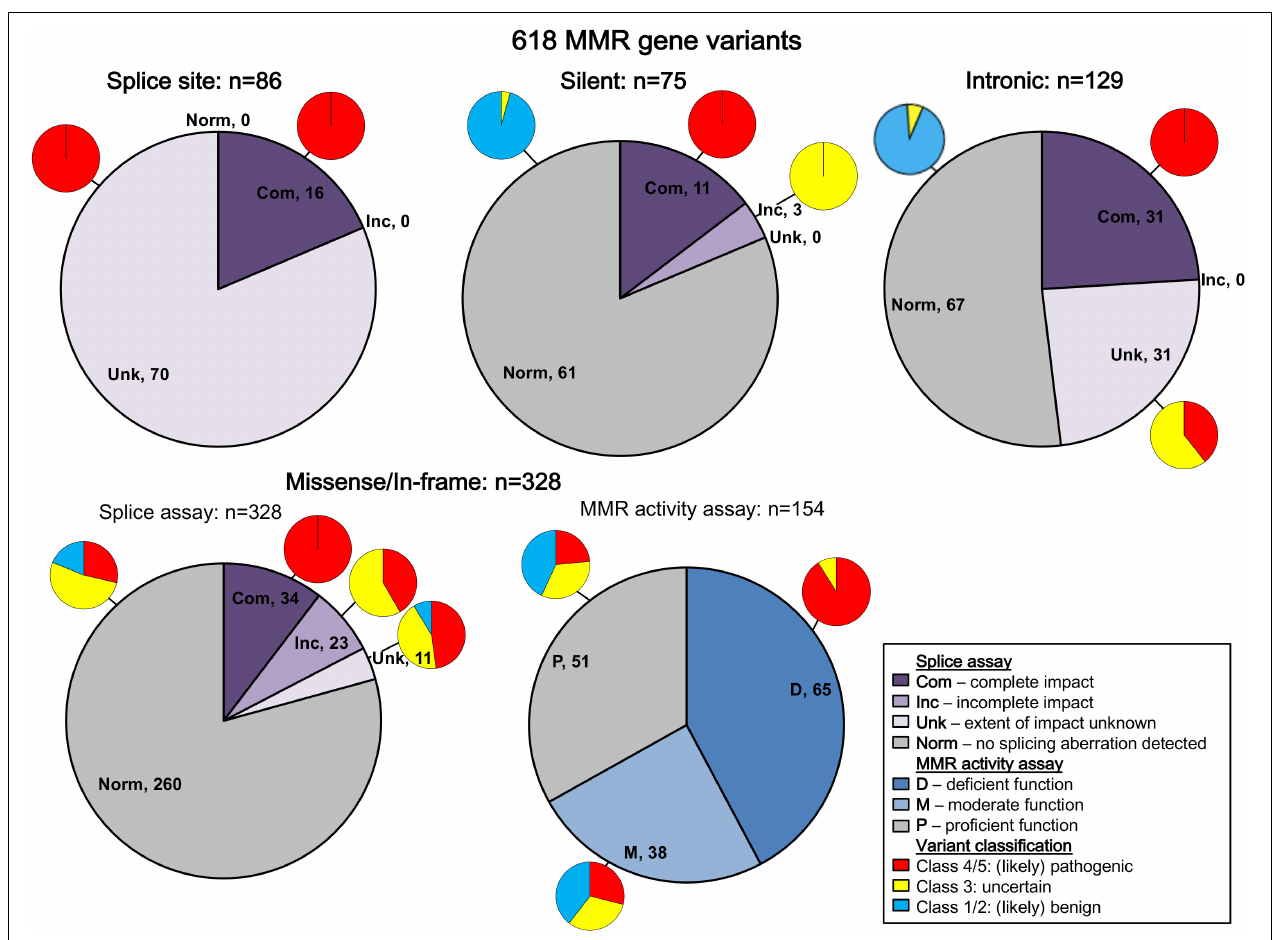
FIGURE 2 | Summary of contribution of splicing assay data to variant classification. The figure legend describes the categorization of the splicing and MMR activity assay data. Splice site refers to variants in the conserved IVS ± 1/2 dinucleotides of the acceptor or donor splice site, while intronic includes all other intronic variants. Predicted loss of function variants other than splice site variants were excluded from this summary because they are classified as pathogenic regardless of splicing assay results (frameshift: n = 25; nonsense: n = 24). There were also two initiation codon variants and two stoploss variants not included in this summary. Com, complete impact, variant allele causes complete splicing aberration; D, deficient function (MLH1/MSH2: < 23% wild-type repair, MSH6/PMS2: < 18% wild-type activity); Inc, incomplete impact, variant allele results in expression of both reference (full-length) and alternatively spliced transcript(s); M, moderate function (MLH1/MSH2: 23% to < 70% wild-type repair, MSH6/PMS2: 18 to < 100% wild-type activity); Norm, no splicing aberration detected; P, proficient function (MLH1/MSH2: ≥ 70% wild-type repair, MSH6/PMS2: ≥ 100% wild-type activity); Unk, extent of impact unknown, splicing aberration detected, but unable to determine if variant impact was